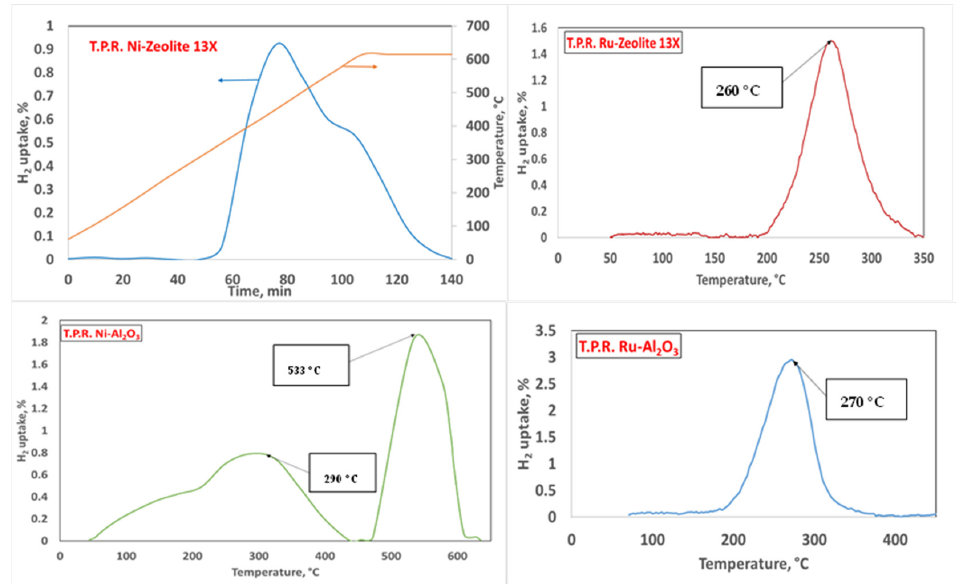
Figure 8. TPR results for the different catalytic samples. Operating conditions: 95% Ar and 5% H 2 . Table 2. Reduction peaks, experimental, and theoretical H 2 consumption for the prepared catalysts as results of the H 2 -TPR.